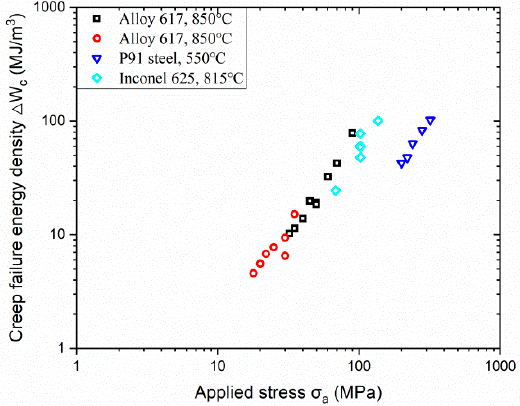
Figure 8. The relation between creep failure density and applied stress.